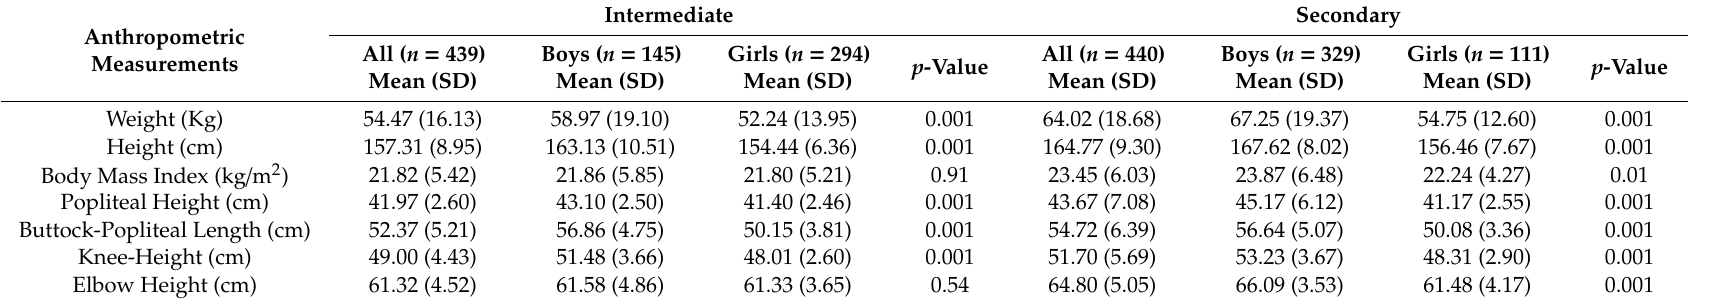
Table 1. Anthropometric measurements of students participated in the study ( n = 879).